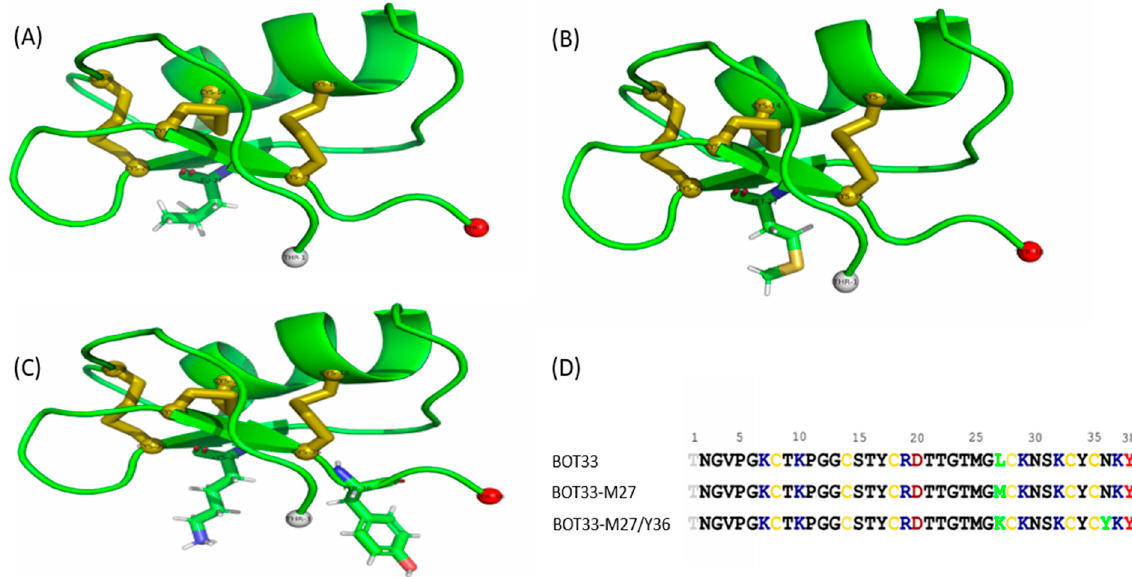
Figure 5. Three-dimensional structure modeling of the Bot33 toxin and its mutated peptides. ( A ) Three-dimensional model of the Bot33 toxin generated by homology modeling. ( B ) Bot33/M27. ( C ) Bot33/K27_Y36. ( D ) Multiple sequence alignment of Bot33 and its sequence